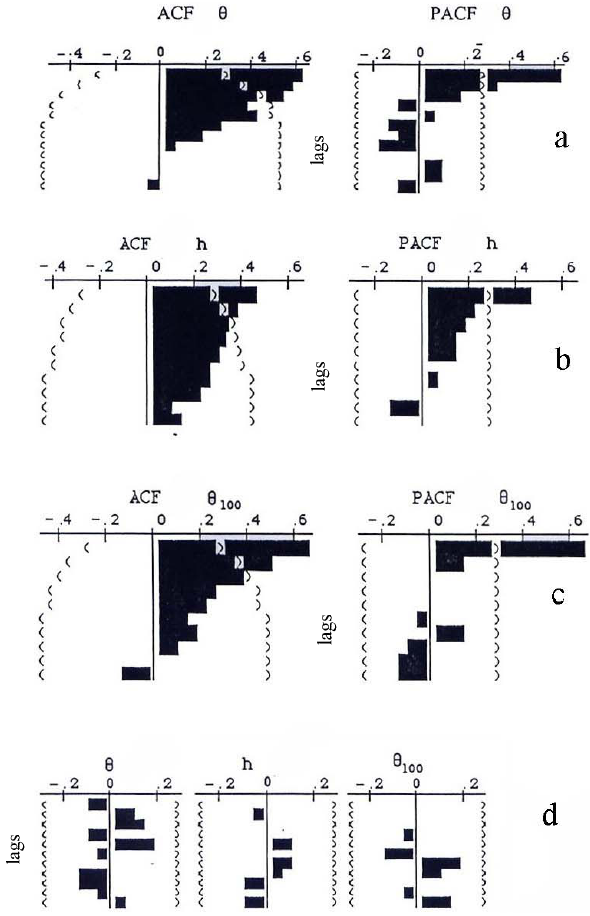
Fig. 6. Estimated ACF and PACF functions with approximate 95% confidence bond, for: (a) soil water content θ 3 , (b) soil water ten- sion h 3 , (c) water content θ 100 , at h = 100cm and (d) noise in model 1 for θ 3 ,h 3 , θ 100